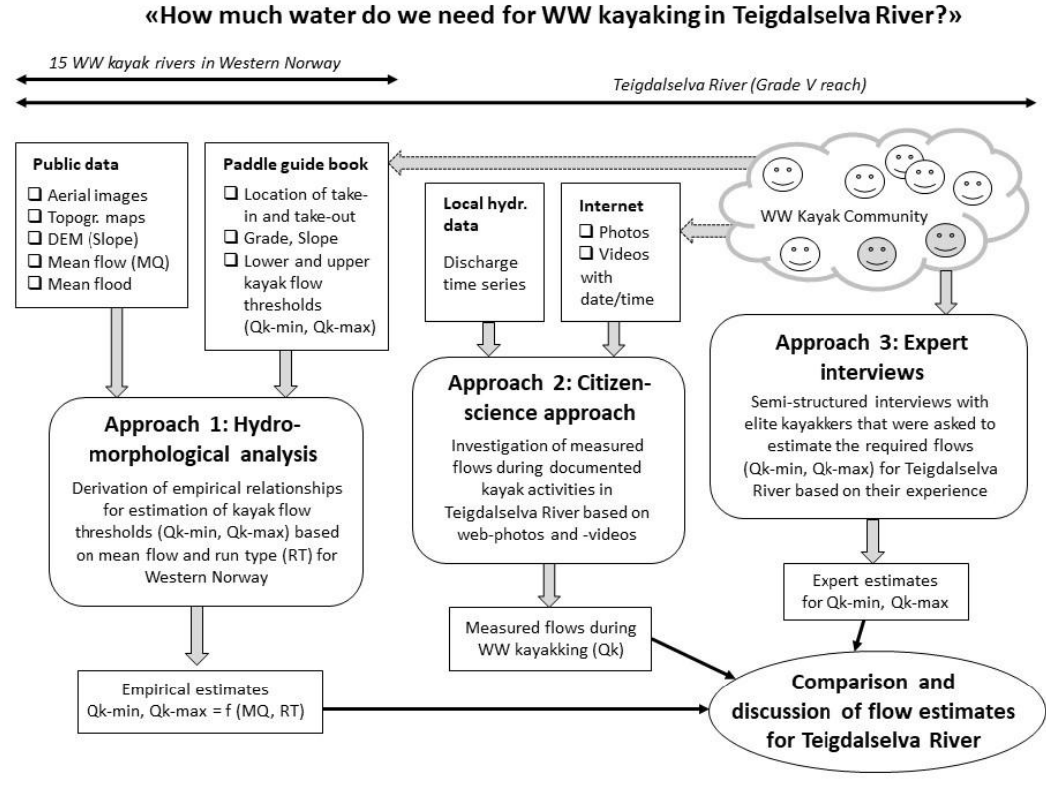
Figure 1. Visual illustration of the objective and the three approaches of the study. The empirical relationships for Approach 1 were derived based on the data from 15 WW kayak rivers in Western Norway. Afterwards, all three approaches were applied to Teigdalselva River.